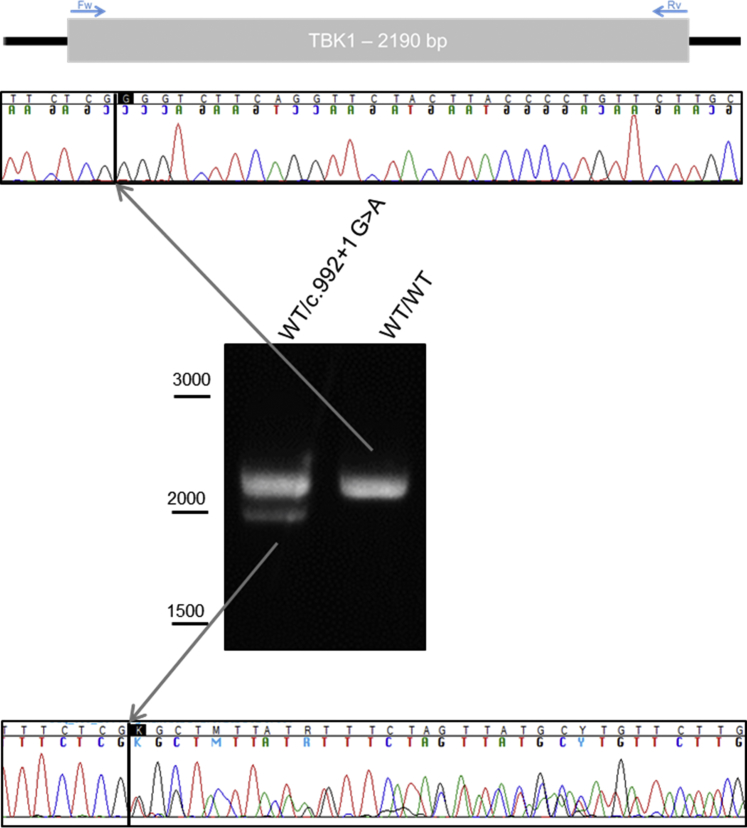
TBK1 variant c.992+1G>A produces the in-framedeletion of exon 8. Agarose gel on cDNA extracted from WT and c.992+1G<A (p.G272-T331 del) LCLs showing two different sized bands for the WT allele and the mutated allele carrying c.992+1G>A compared to the sample carrying both WT alleles (WT/C992+1G>A WTallele: 2190 bp, WT/C992+1G>A mutated allele: 1990bp, WT/WT: 2190bp). The boxes above and below show the sequencing of the WT/WT sample and the sequencing of the WT/c.992+1G>A sample, respectively.